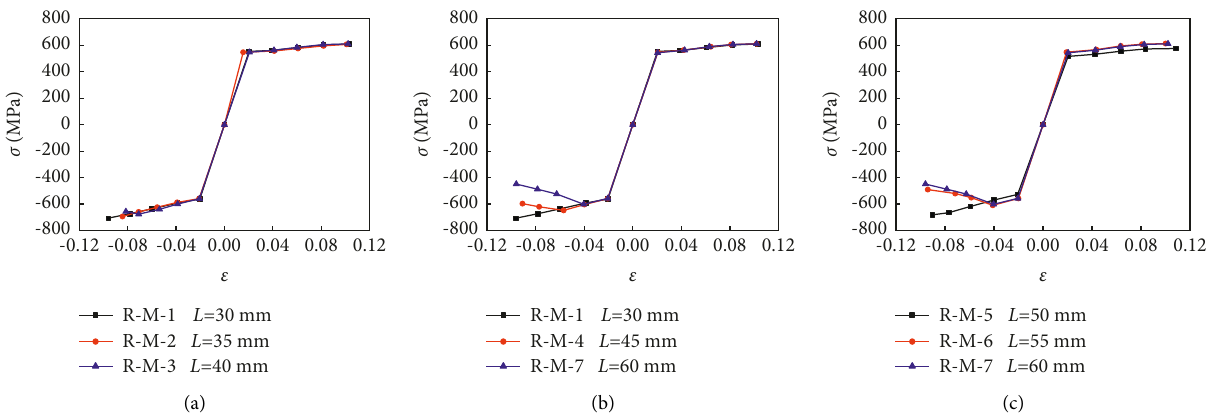
Figure 19: Skeleton curves of material specimens with different lengths in the tensile zone. (a) Specimens with a small length in the tension zone. (b) Specimens with larger length in the tension zone. (c) Specimens with large length in the tension